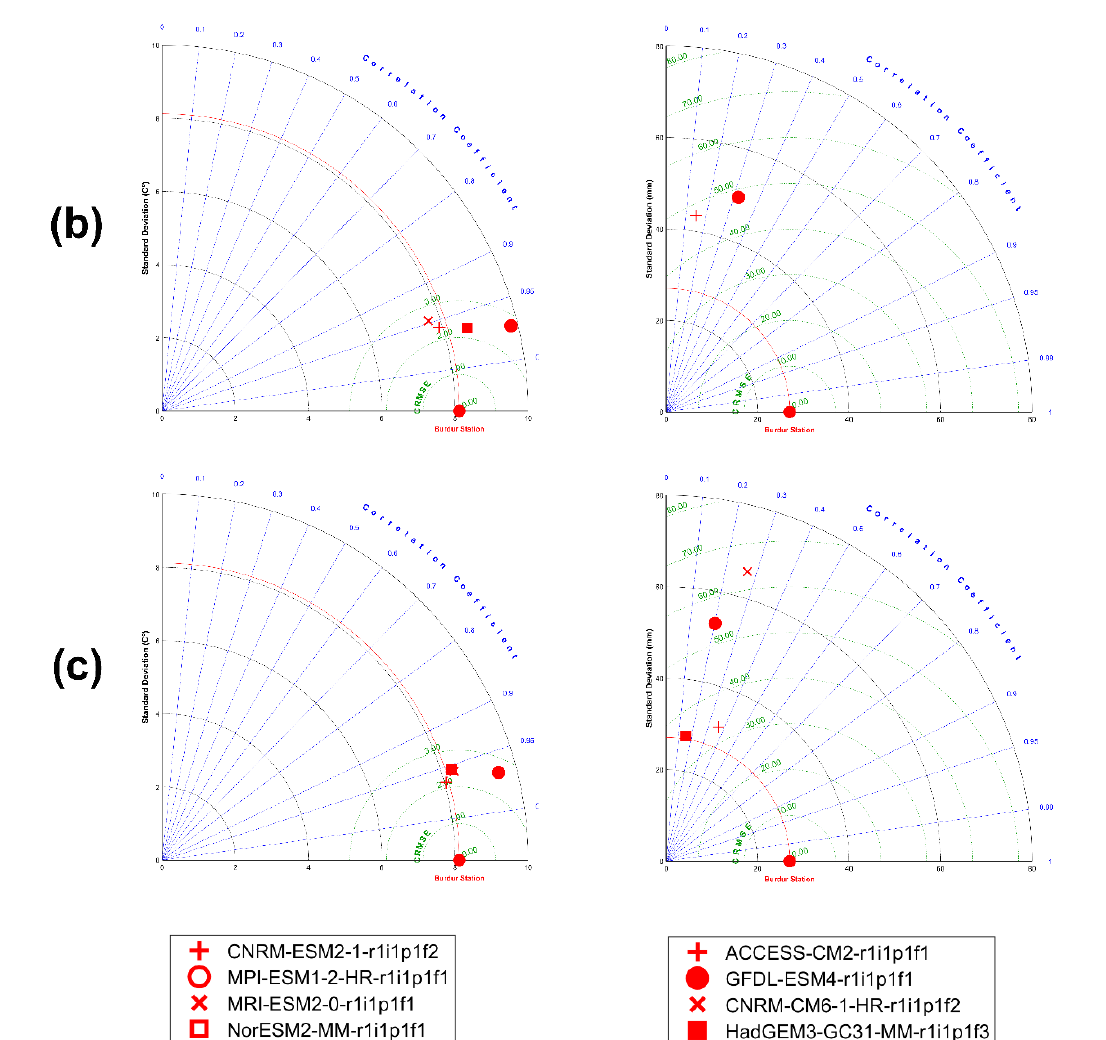
Figure A1. Taylor diagrams for temperature and precipitation comparison for the historical period (1970–2014) ( a ); the validation period (2015–2020) of R245 simulation ( b ); and the validation period (2015–2020) of R585 simulation ( c